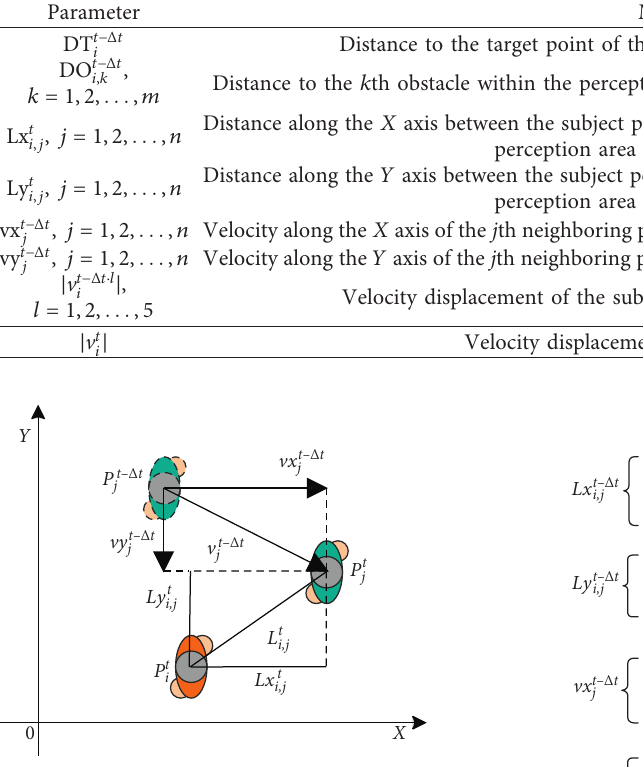
Figure 2: Schematic diagram of the distance between the subject pedestrian and neighboring pedestrian in the perception area as well as velocity of the neighboring pedestrian along the X and Y axes. The orange circle represents the subject pedestrian, and green circles represent the neighboring pedestrian.